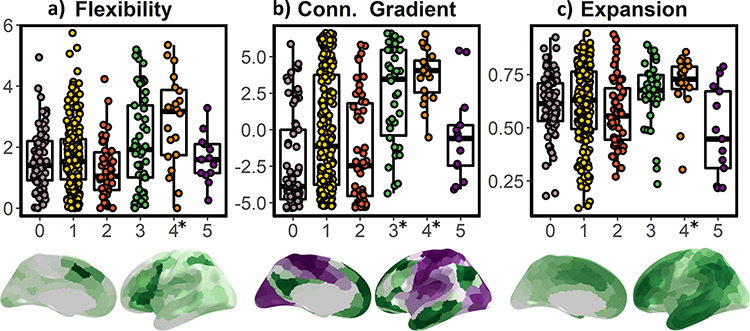
Topological relationship between encoding clusters and functional and evolutionary hierarchy. (a) Flexibility (Yeo et al. 2015), (b) specialization determined by the principal gradient of functional connectivity (Margulies et al. 2016), and (c) macaque-human expansion (Van Essen and Dierker 2007; Hill et al. 2010). Y-label represents the number of recruited components, distance (mm), and normalized (0–1) expansion, respectively. Conn. Gradient = principal gradient of functional connectivity. *Denotes significance after permutation testing.